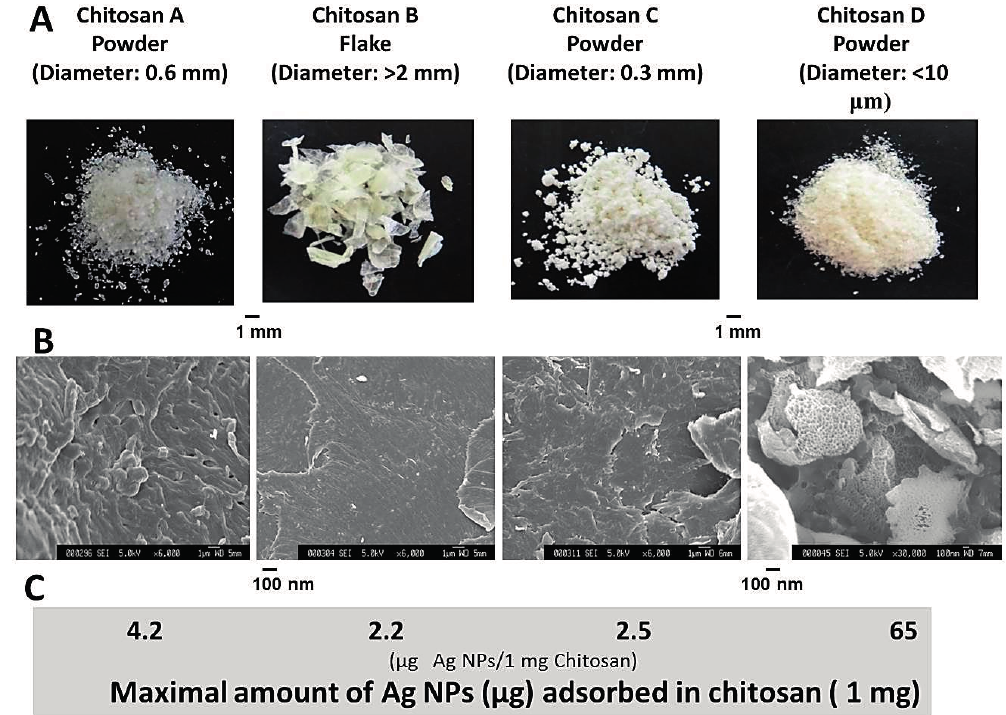
Figure 5. SEM images of chitosan surfaces and binding of Ag NPs. Adsorption of Ag NPs to chitosans with nanoscale porous surface structures was higher than to chitosans with flat/smooth film-like surface structures. ( A ) Appearance of each chitosan powder (flake); ( B ) SEM micrographs of each chitosan; ( C ) Binding of Ag NPs onto each